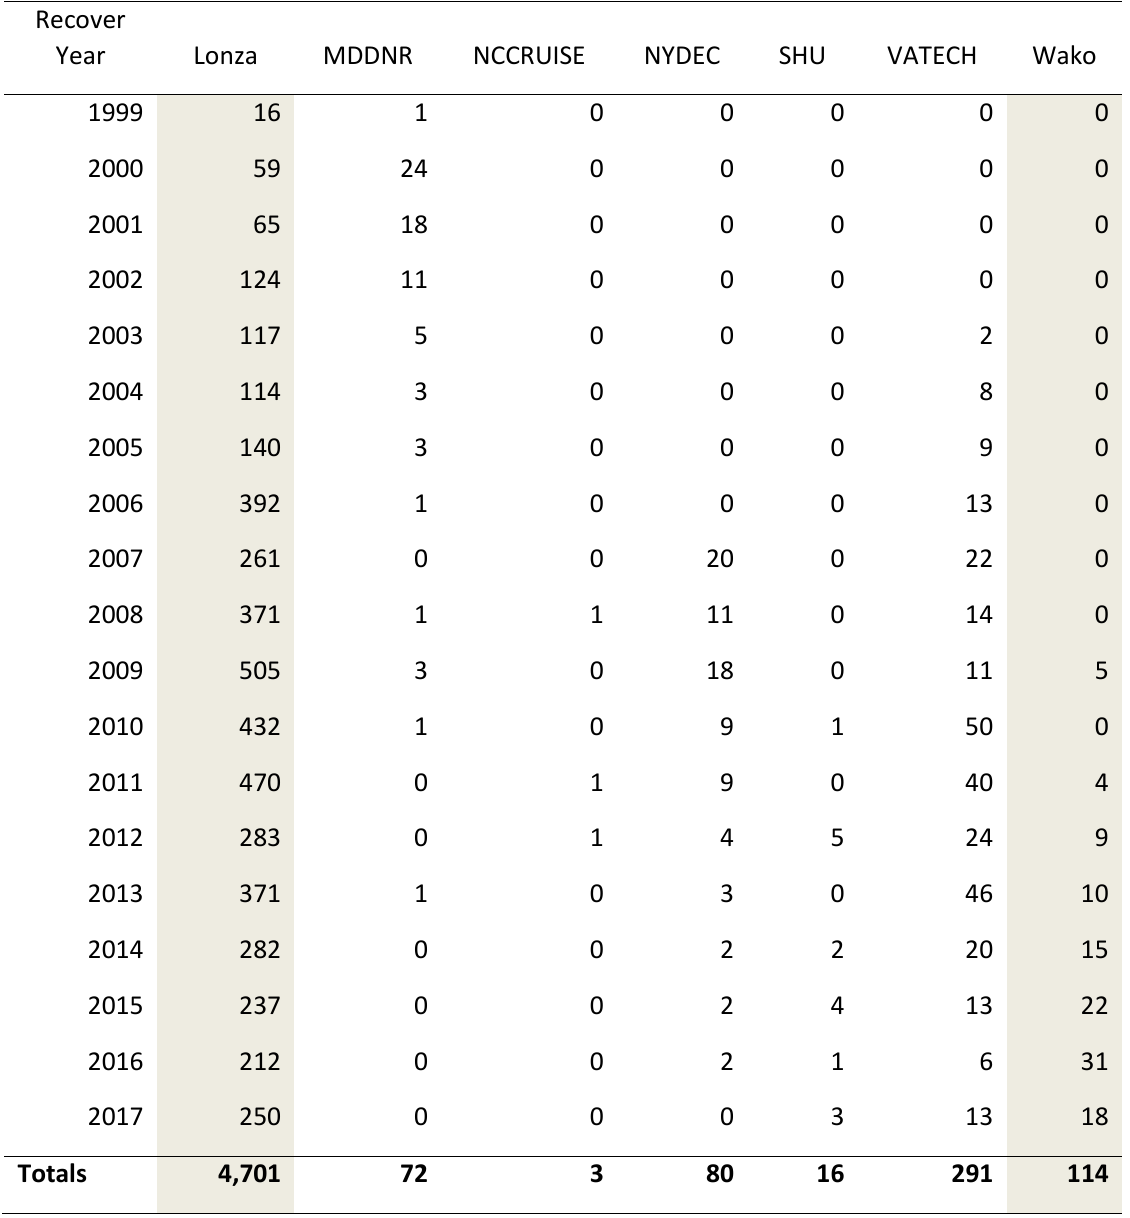
Table 18. List of recaptured trawl-tagged crabs since 1999. Shaded gray columns indicate biomedical companies that tag bled crabs (Lonza and